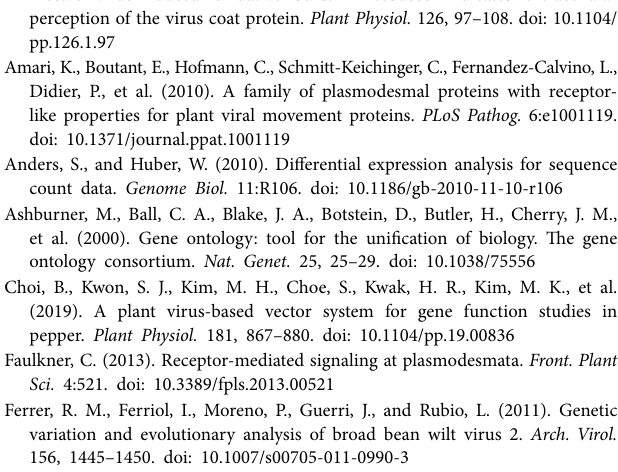
Supplementary Table S4 | Validation of RNA sequencing data by quantitative real-time